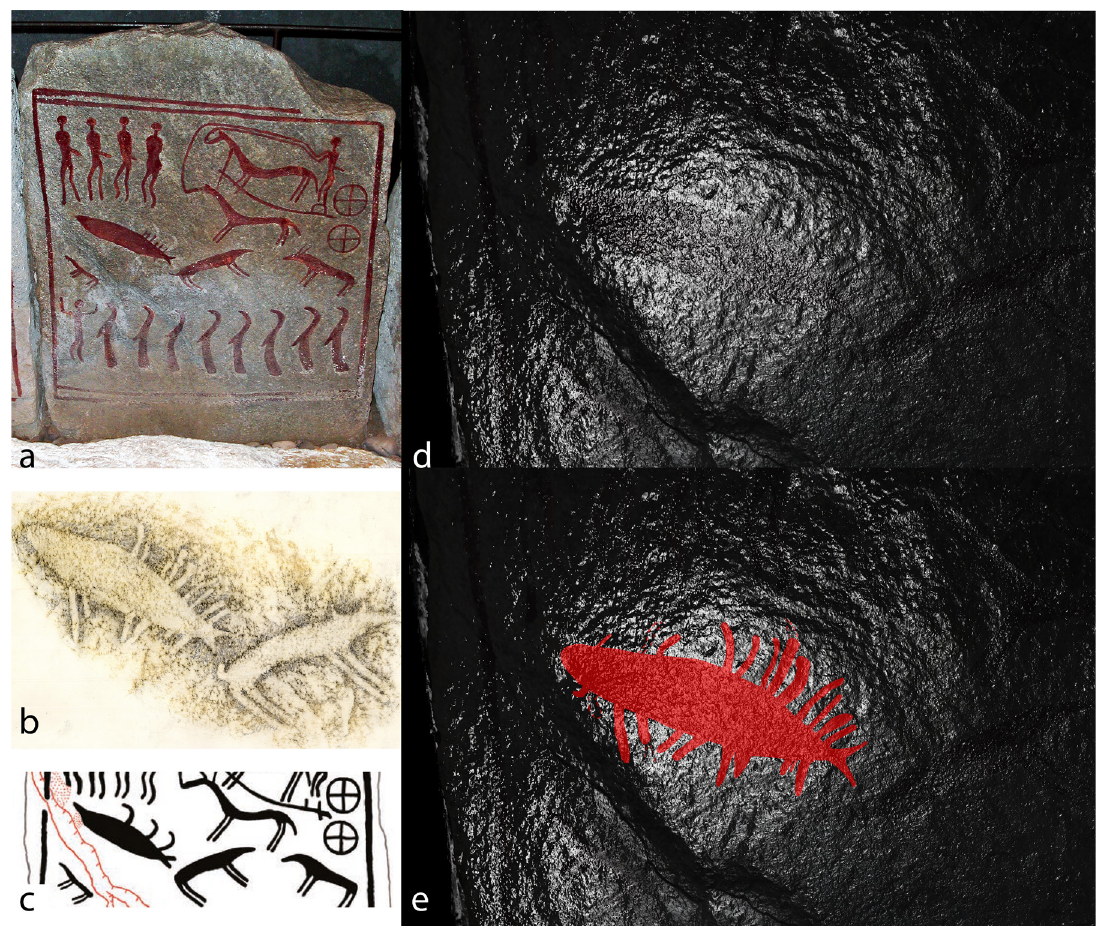
Figure 4. a. Photography of slab 6 in the Bredarör tomb, Kivik by Catarina Bertilsson (the red paint is applied by the heritage service to make the engravings better visible to the public); b. Frottage of the fish by Dietrich Evers; c. Result of the tracing by Andreas Toreld and Tommy Andersson (2015); d. RTI of the fish; e. Fish indicated; Figures 4d–e by RP &